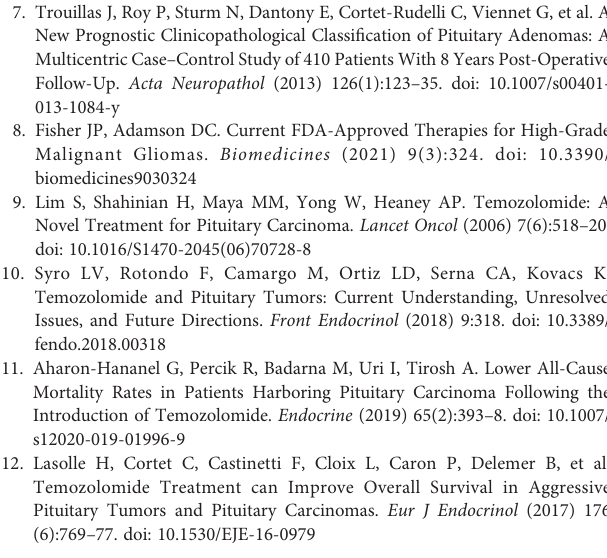
Supplementary Figure 1 | Schematic representation of the work fl ow for selection of aggressive pituitary adenomas for temozolomide therapy. TMZ, Temozolomide; NFPA, Non-functioning pituitary adenoma; D2A, Dopamine receptor agonist; SRL, Somatostatin receptor ligand. Supplementary Figure 2 | Graph depicting the hormonal and tumoral response of each individual patient to temozolomide. The fi rst 11 patients were non- responders while the remaining 24 were